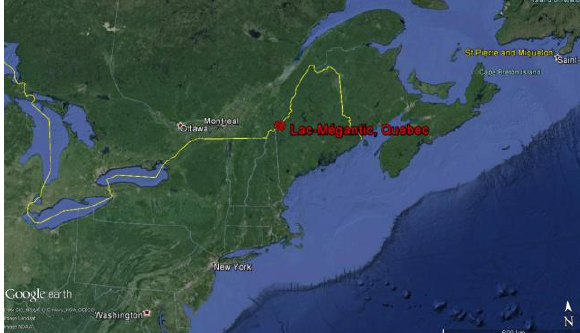
Figure 1. The Location of Lac-Mégantic is approximately 140 km southeast of Quebec City, Quebec,